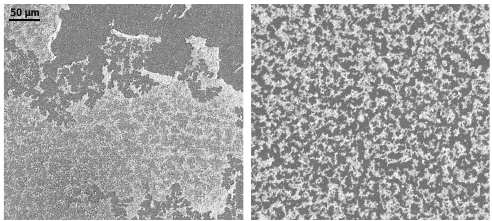
Figure A2. SEM image of polyethylene surface for non-ESD ( left ) and ESD ( right ) scaled to 50 µm.